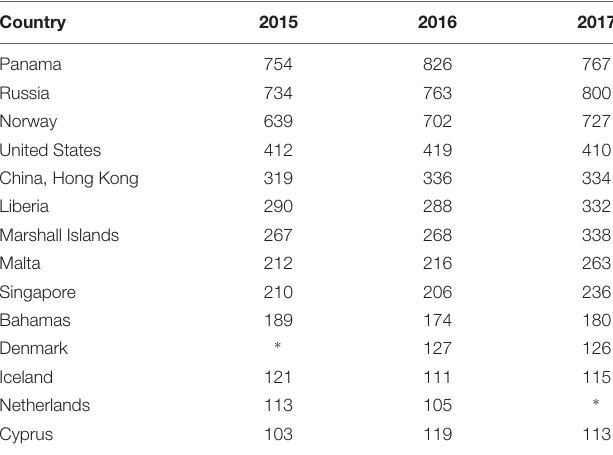
TABLE 2 | Nations with > 100 flagged vessels operating in Arctic waters and number of registered ships, 2015–2017.